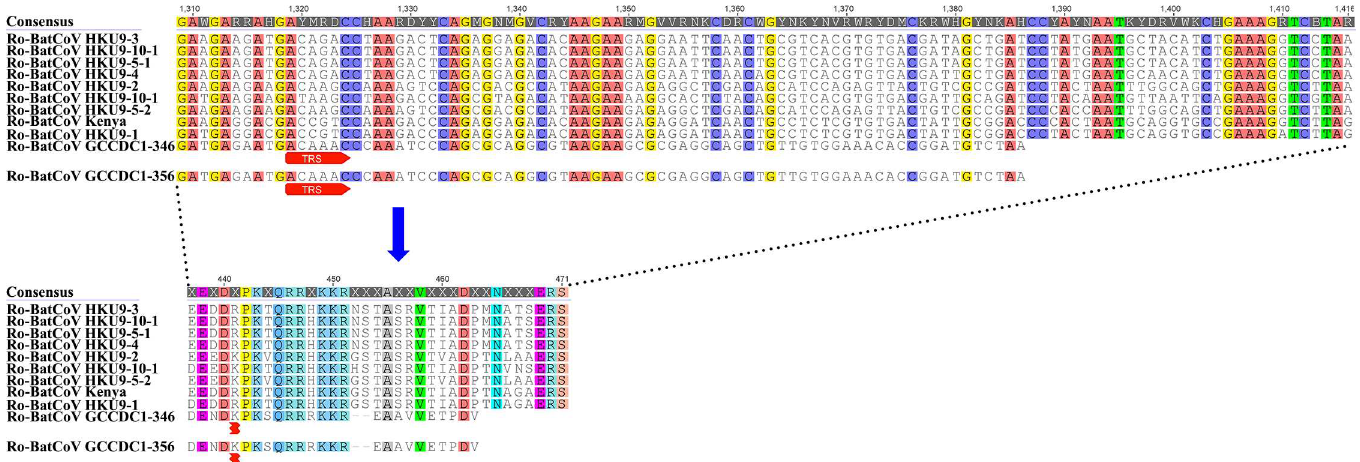
Fig 5. Comparison of the 3'-terminus of the N geneof Ro-BatCoVGCCDC1 withthoseof Ro-BatCoVHKU9 strainsand Ro-BatCoVKenya. Alignmentof nucleotide and aminoacid sequence of the 3'-terminus of the N gene among Ro-BatCoV GCCDC1,Ro-BatCoV HKU9 strains and Ro-BatCoV Kenya. The eightamino acid truncationand two-amino-aciddeletionat the 3’-terminusof N proteinof the Ro-BatCoV GCCDC1are illustrated.